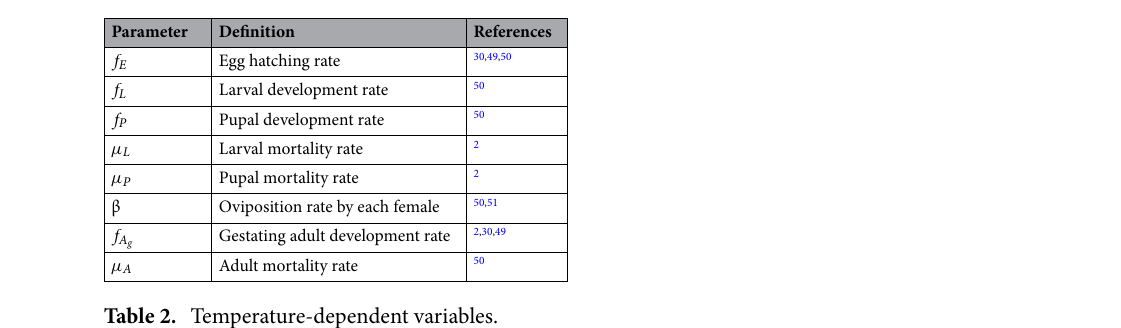
Table 2. Temperature-dependent variables.